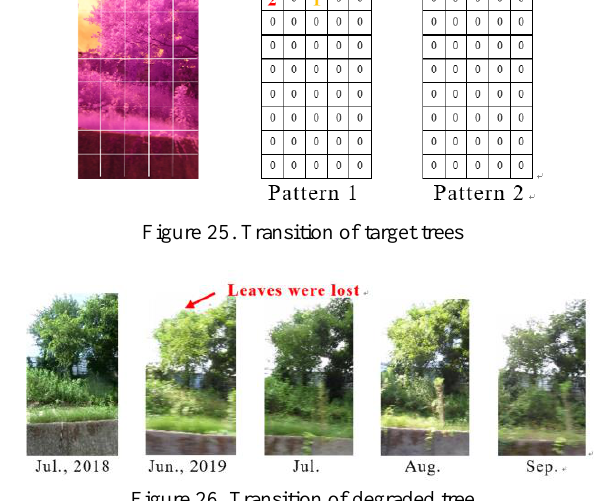
Figure 26. Transition of degraded